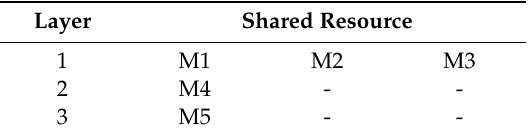
Table 2. Shared resources of each layer.